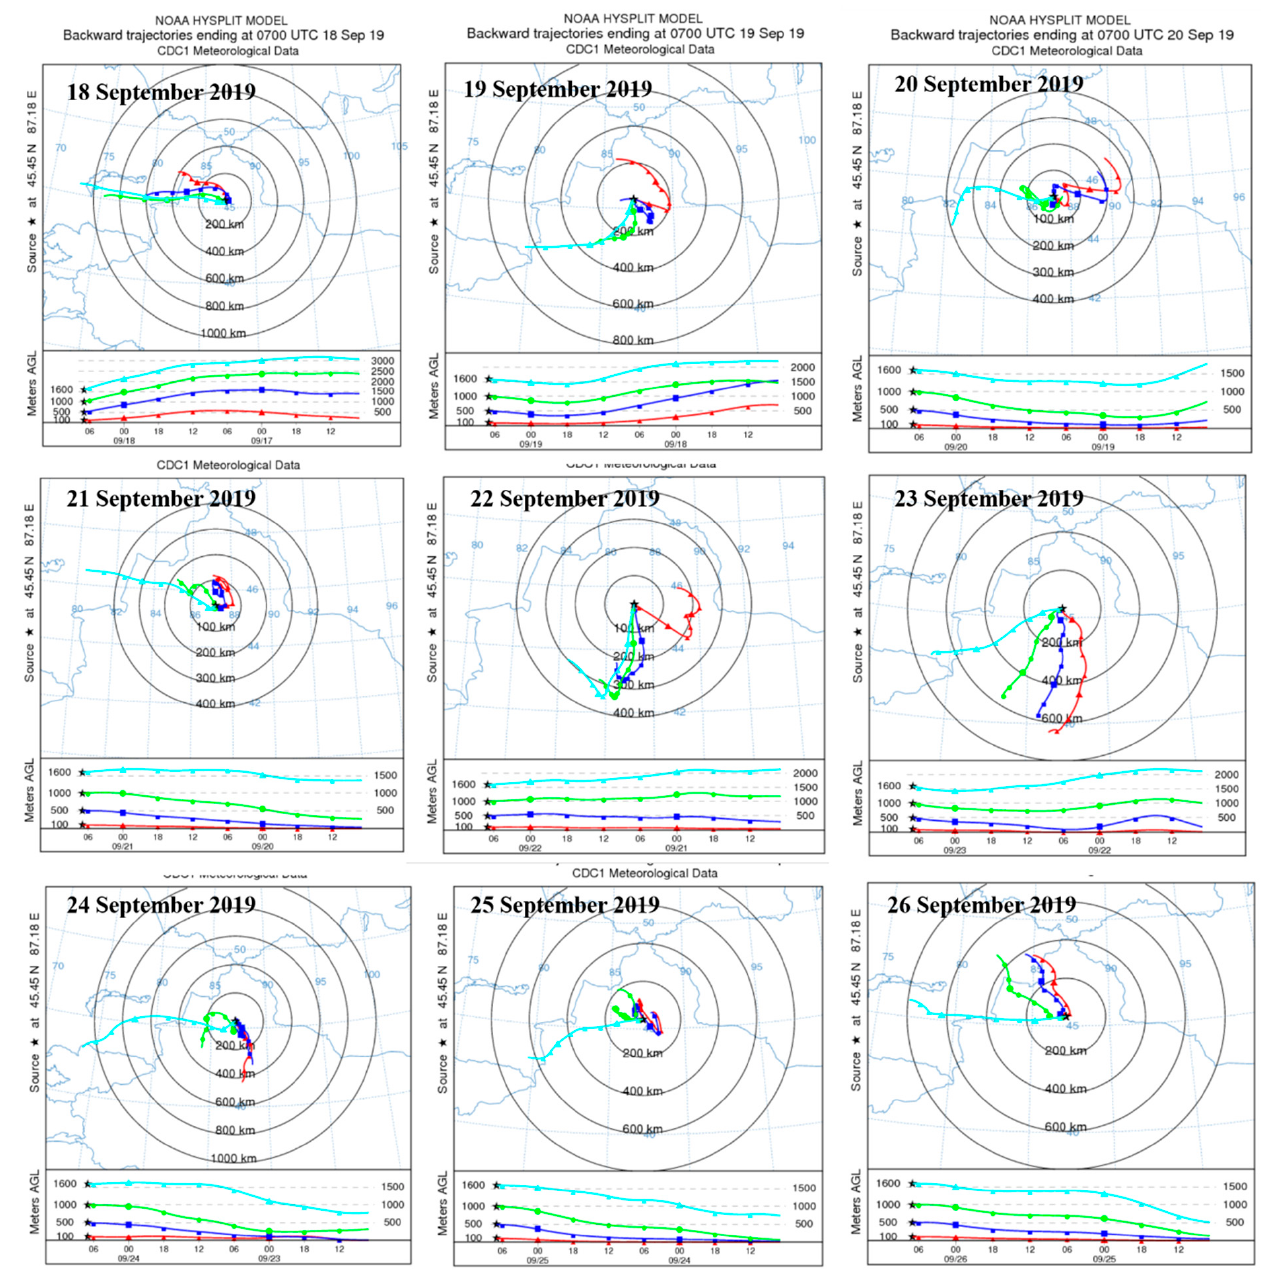
Figure 8. 48 h backward trajectories at different heights above observation site at 15:00.